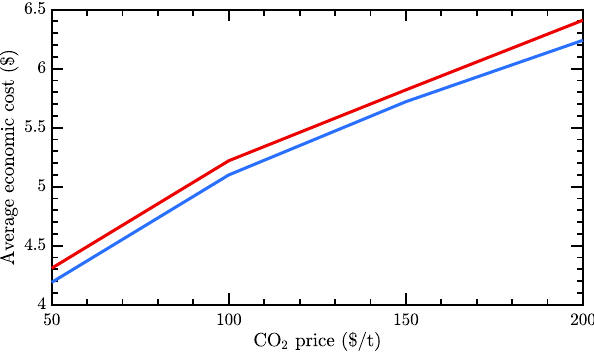
Figure 13. Average economic performance of the controllers under scenario 2 at different CO 2 prices. EMPC (blue), MPC (red).